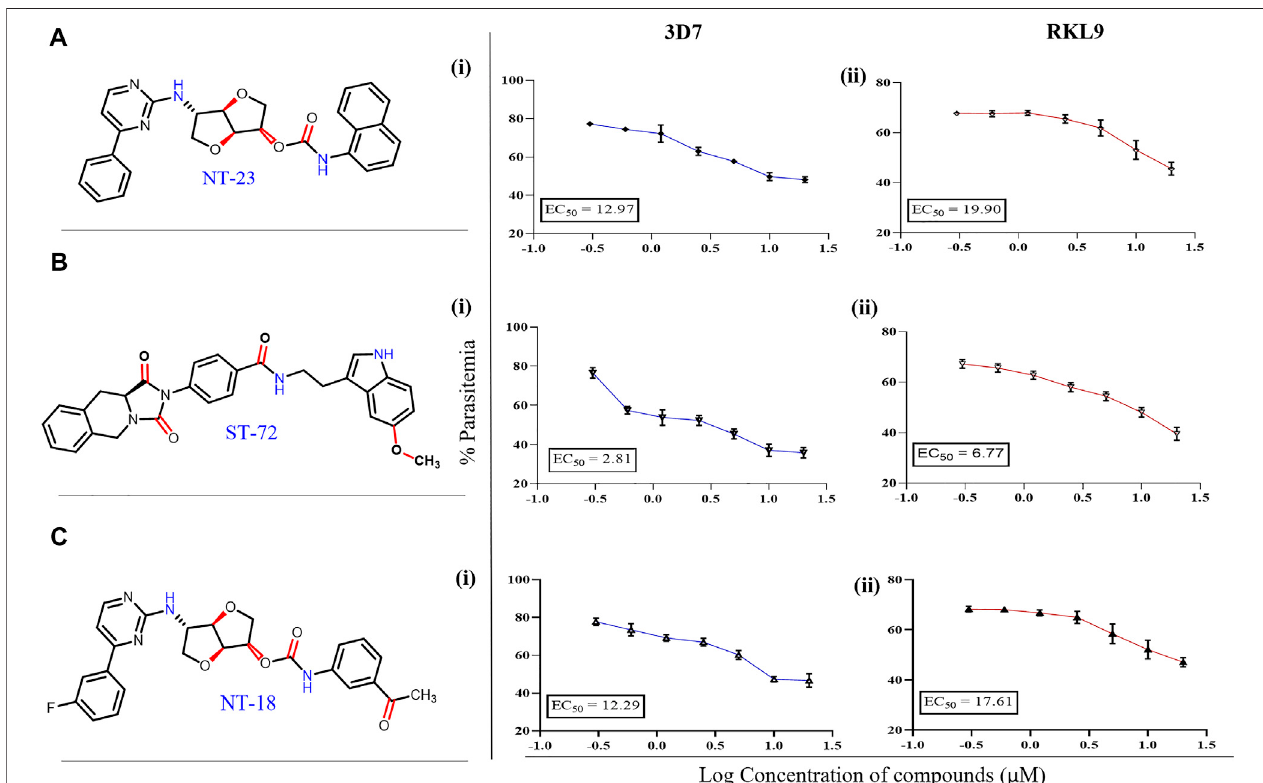
FIGURE 3 | (A – C) Growth inhibitory effect of compounds NT23, ST72, and NT18 on 3D7 and RKL-9. The parasite culture synchronized at ring stage was treated withdifferent concentrations(0.3 – 20 µM) ofthese compounds for72 h s,and the percent growth inhibition wasestimated bytheSYBR Green fl uorescence assay. IC 50 valuesofeach compound in3D7(i)andRKL-9(ii)wereevaluatedbyplottinggrowthinhibitionvaluesagainstthelogconcentrationofthesecompounds. Theexperiment was done in triplicate, and the results were shown as mean values ± SD.